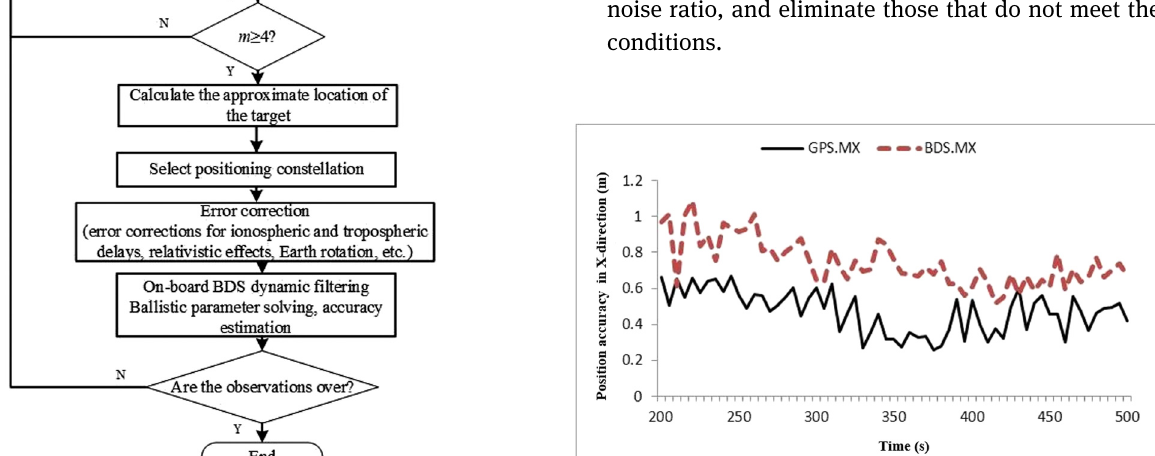
Figure 4: Position precision of on - board BDS and GPS in X -